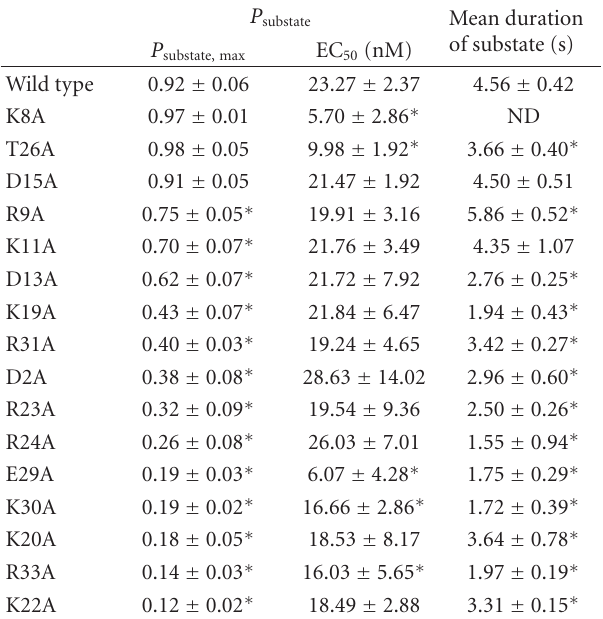
Table 1: E ff ects of the mutant IpTx a on P substate of native RyR1 in SR. P substate, max and EC 50 for P substate, max were calculated using (1) as described in “Section 2.” Values are means ± SE of 3–9 experiments. The average lengths of the substate events were determined at 30nM concentration. Asterisks indicate significant di ff erences from the wild-type toxin for each parameter (Student t -test, P < 0 . 05). ND: not